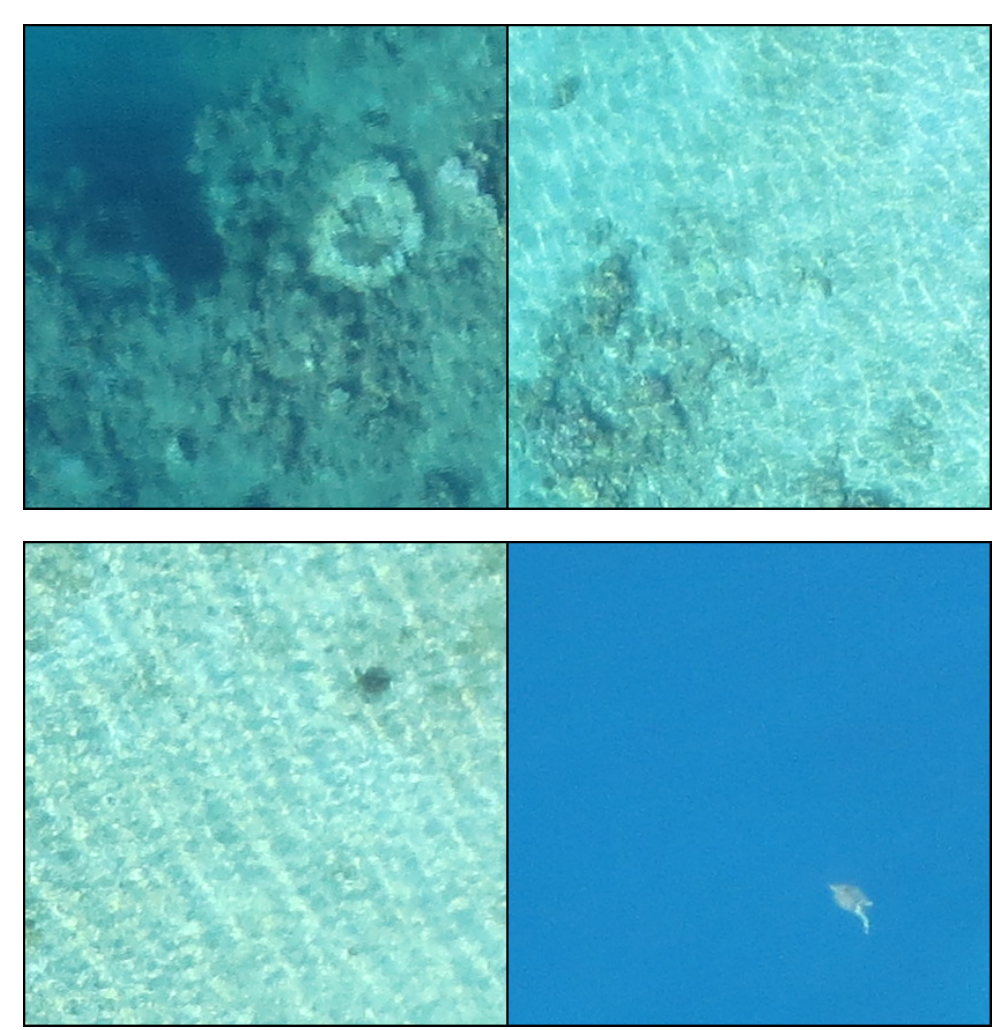
Figure 7. Normal ( top ) and anomalous ( bottom ) images from the Kelonia